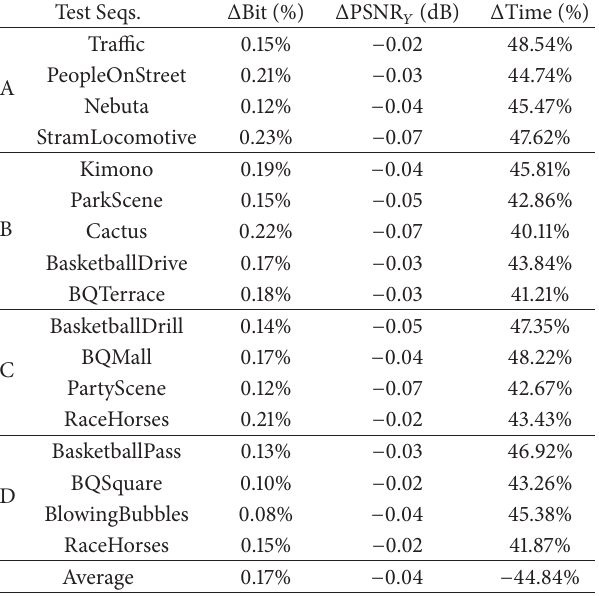
Table 3: The performance of the proposed fast scheme. Test